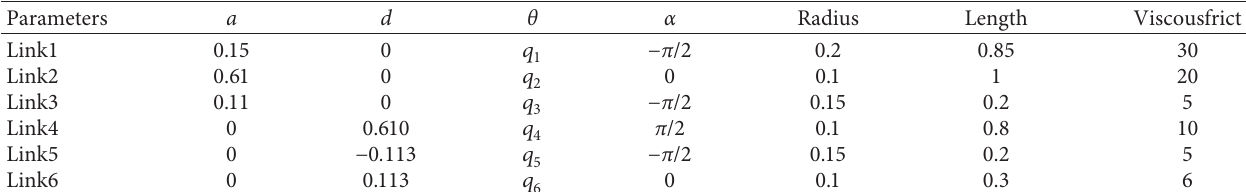
Table 2: Denavit–Hartenberg parameters (m, rad), radius (m), length (m), and viscous friction (Nms) of the manipulator mounted on the underwater